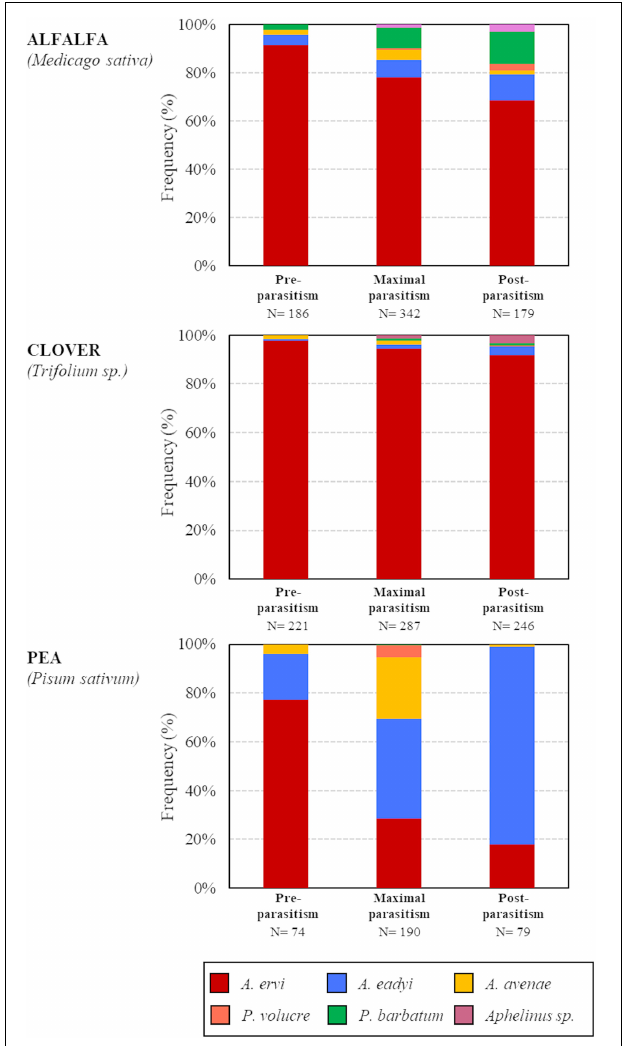
FIGURE 2 | Frequencies of the parasitoid species in the different pea aphid biotypes (“alfalfa,” “clover,” and “pea”) at different parasitism period (“pre-parasitism,” “maximal parasitism,” and